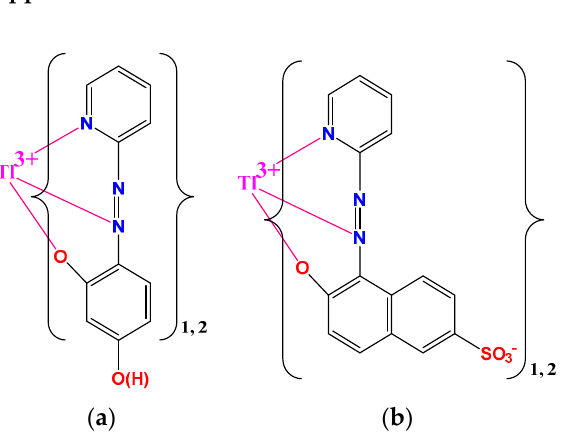
Figure A1. Description of system Tl(III)-PAR vs. Tl(III)-PANS: ( a ) Tl(III)-PAR 4-(2-pyridylazo)resorcinol (PAR); ( b ) Tl(III)-PANS 2-(2-pyridylazo)-1-naphthol-4-sulfonic acid (PANS).